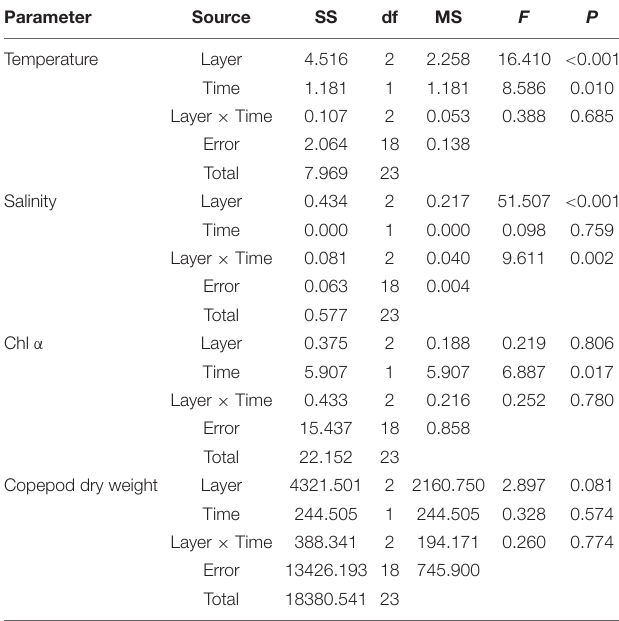
TABLE 2 | Two-way ANOVA testing for difference in environmental parameters between layers (upper, middle, and bottom layers) and time (day or night). Parameter